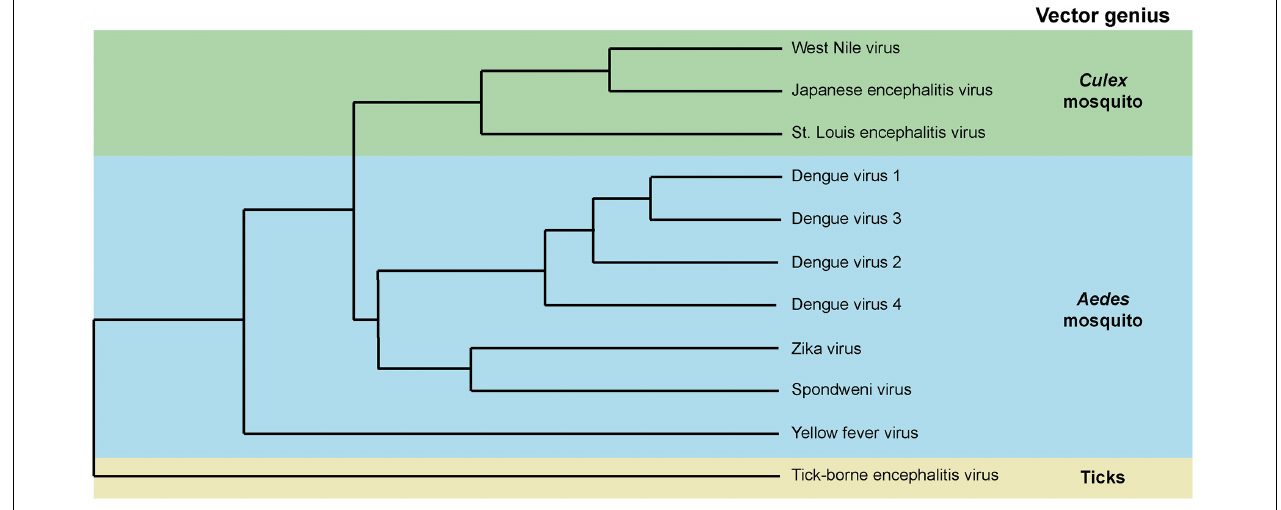
FIGURE 1 | Phylogenetic distribution of mosquito-borne flaviviruses and their associated vectors. Dendrogram based on amino acid sequences.